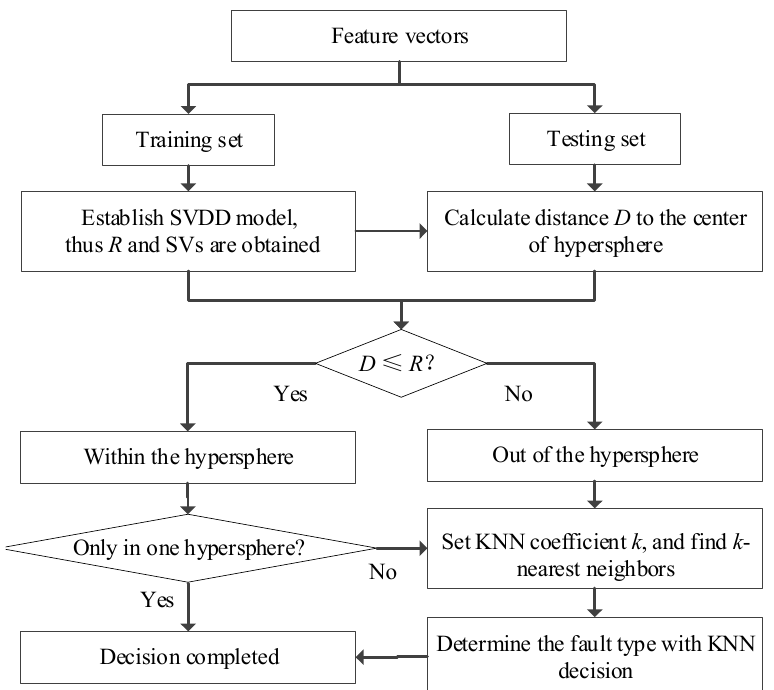
Figure 2. The flowchart of support vector data description with improved decision strategy (ID-SVDD).